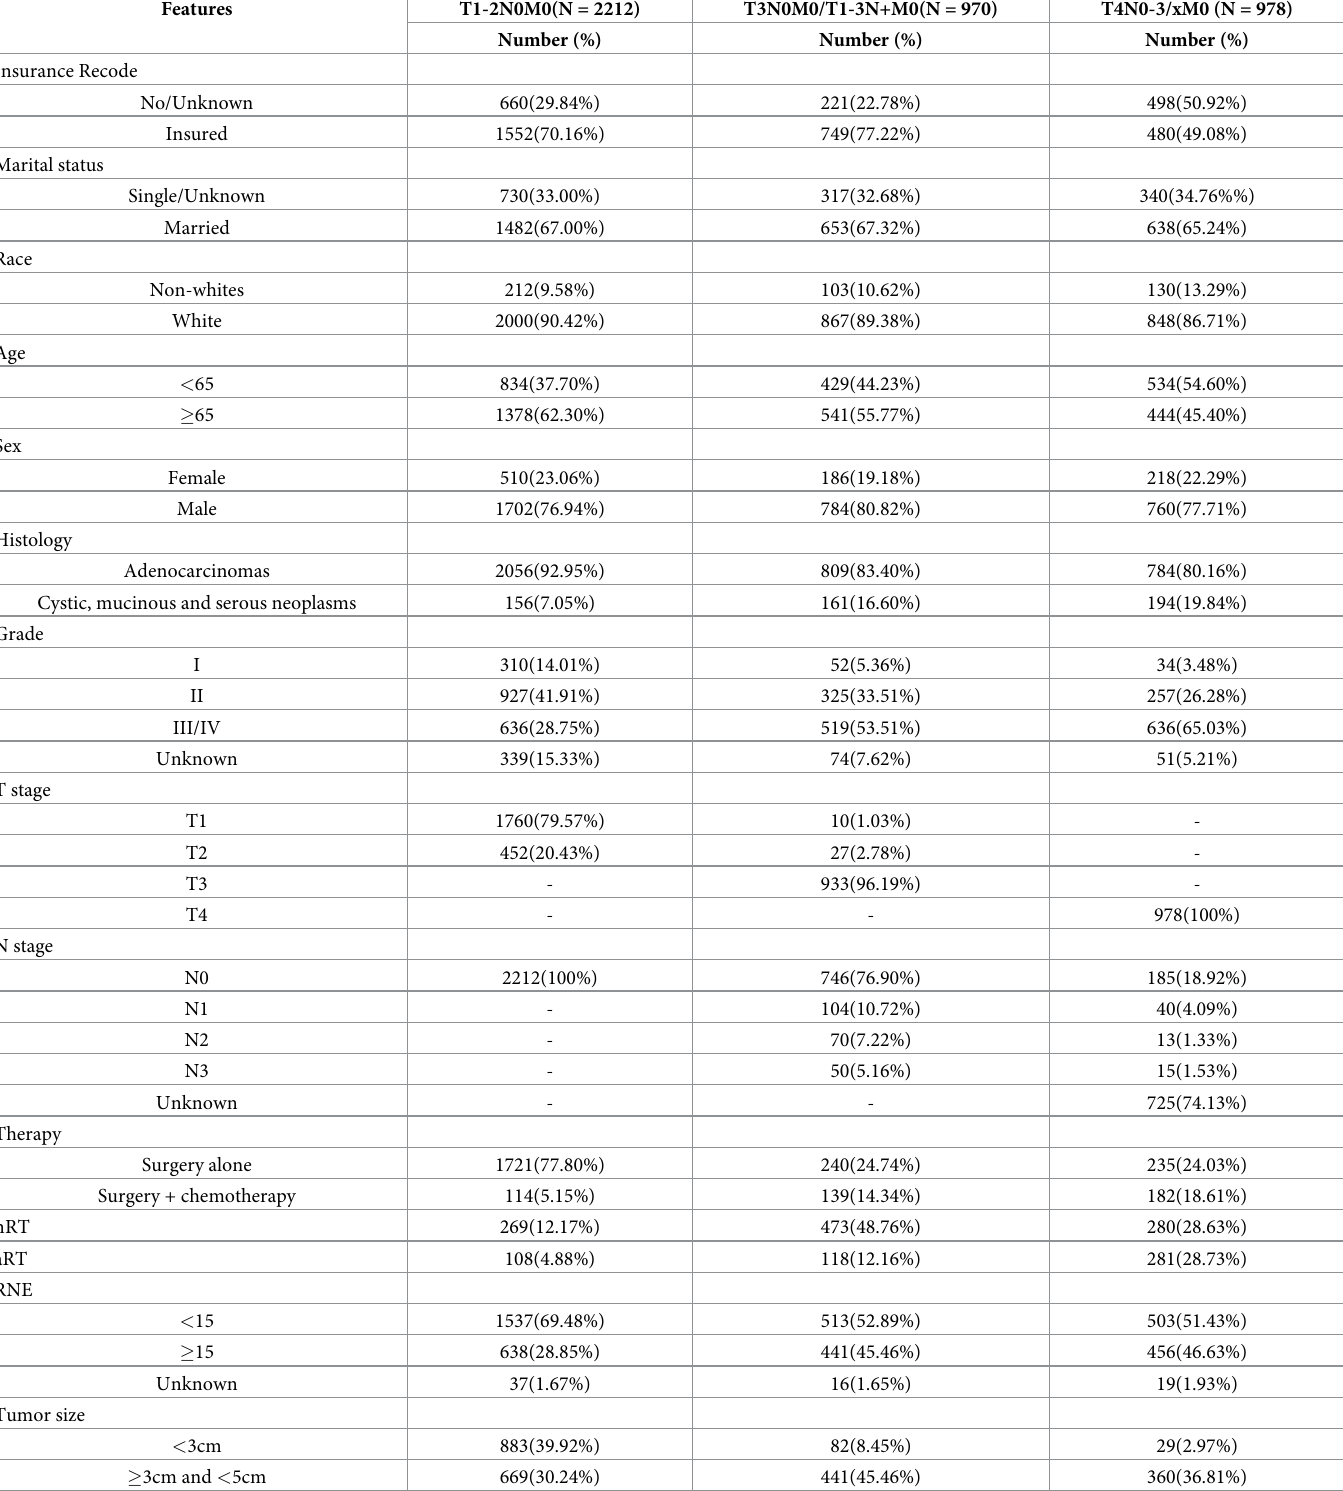
Table 1. The basic clinicopathological features of patients with Siewert type II